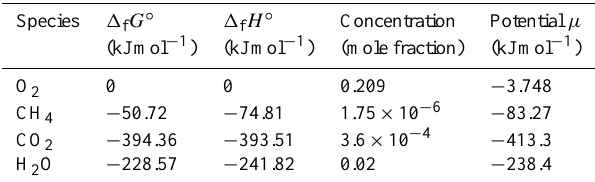
Table 1. Thermodynamic data for the four species we consider, in gas phase, tabulated at unit pressure and T 0 =298K (taken from Atkins, 1994); the surface concentrations we assume in our calcu- lation; and the species’ chemical potentials in the gas phase near the surface, calculated using Eq. (20) with T =288K. These figures lead to a 1 x G of 799kJmol − 1 for the non-spontaneous conversion of CO 2 and H 2 O into O 2 and CH 4